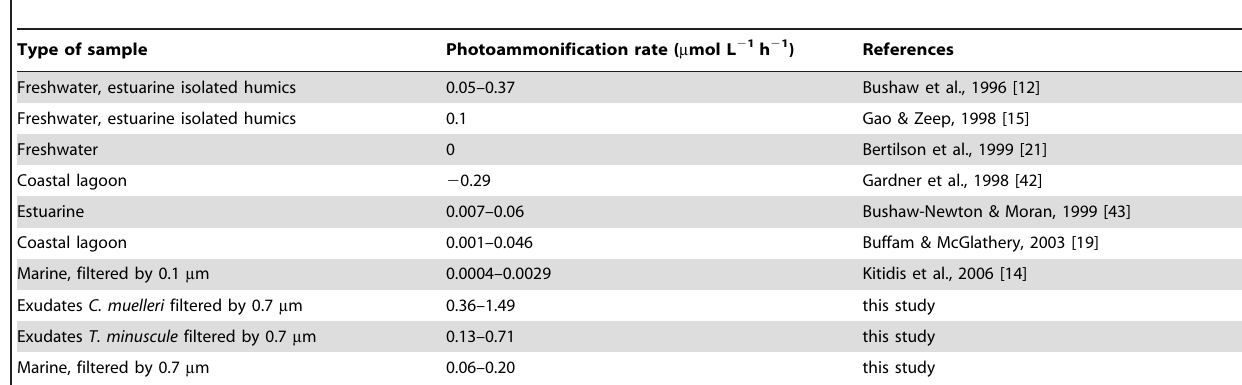
Table 4. Comparison between rates of photoammonification obtained from the literature for freshwater, estuarine and marine environments and results obtained from this study ( m mol L 2 1 h 2 1